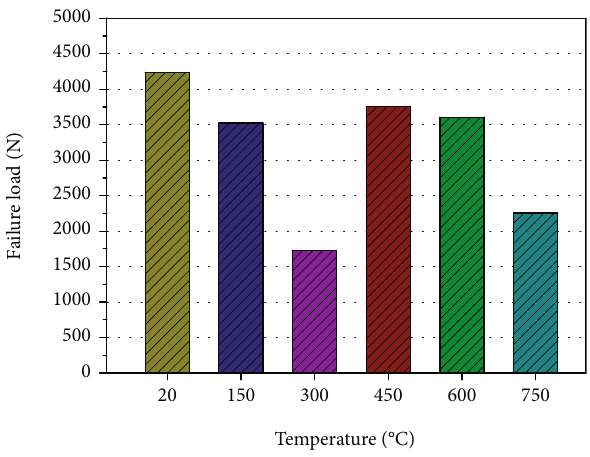
Figure 6: Variation of the maximum failure load with respect to environment temperature for the studied CMC/superalloy double bolted